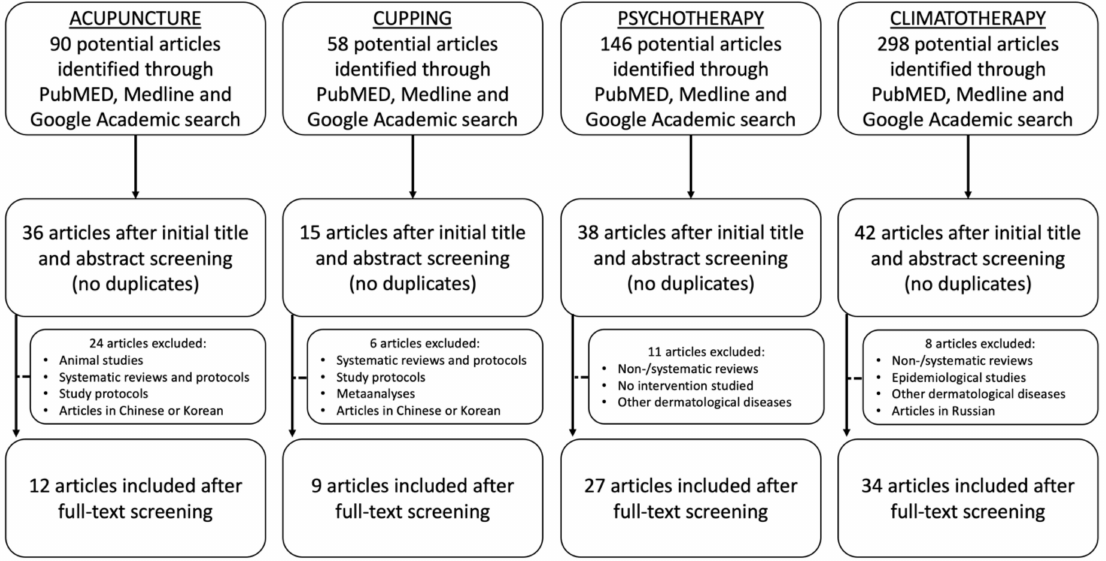
Figure 1. Analytical flow-chart of the employed article selection and elimination